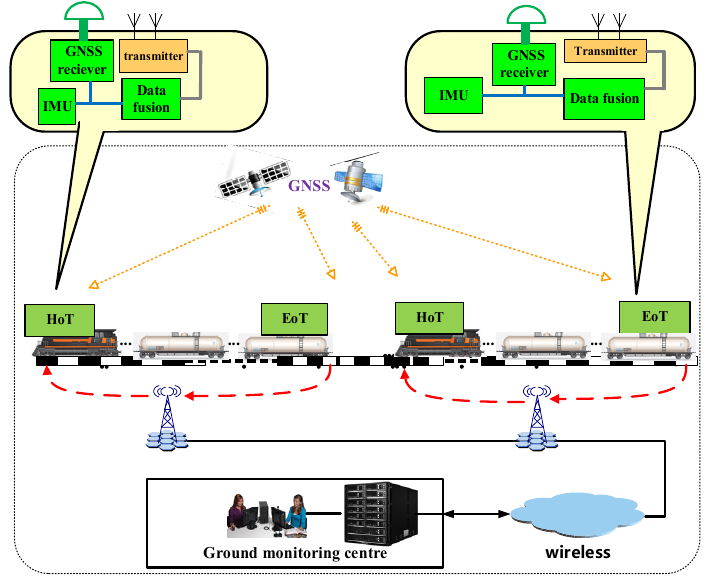
Figure 1. Structure of a typical GNSS-based TIMS.